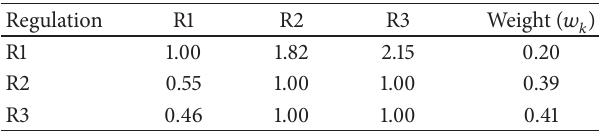
Table 9: The results of pair-wise comparison for subprecursors of